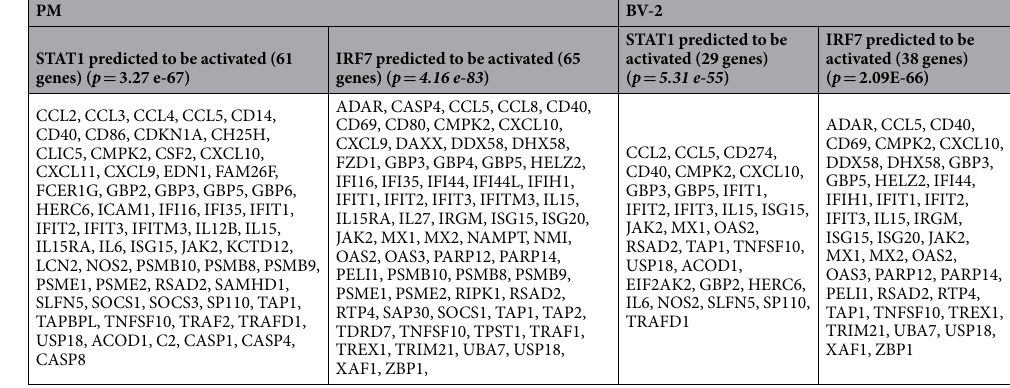
Table 4. Leads to activation of inflammatory genes by identified TFs in response to GSK-J4 inhibited LPS induced inflammatory genes in PM and BV-2 microglial